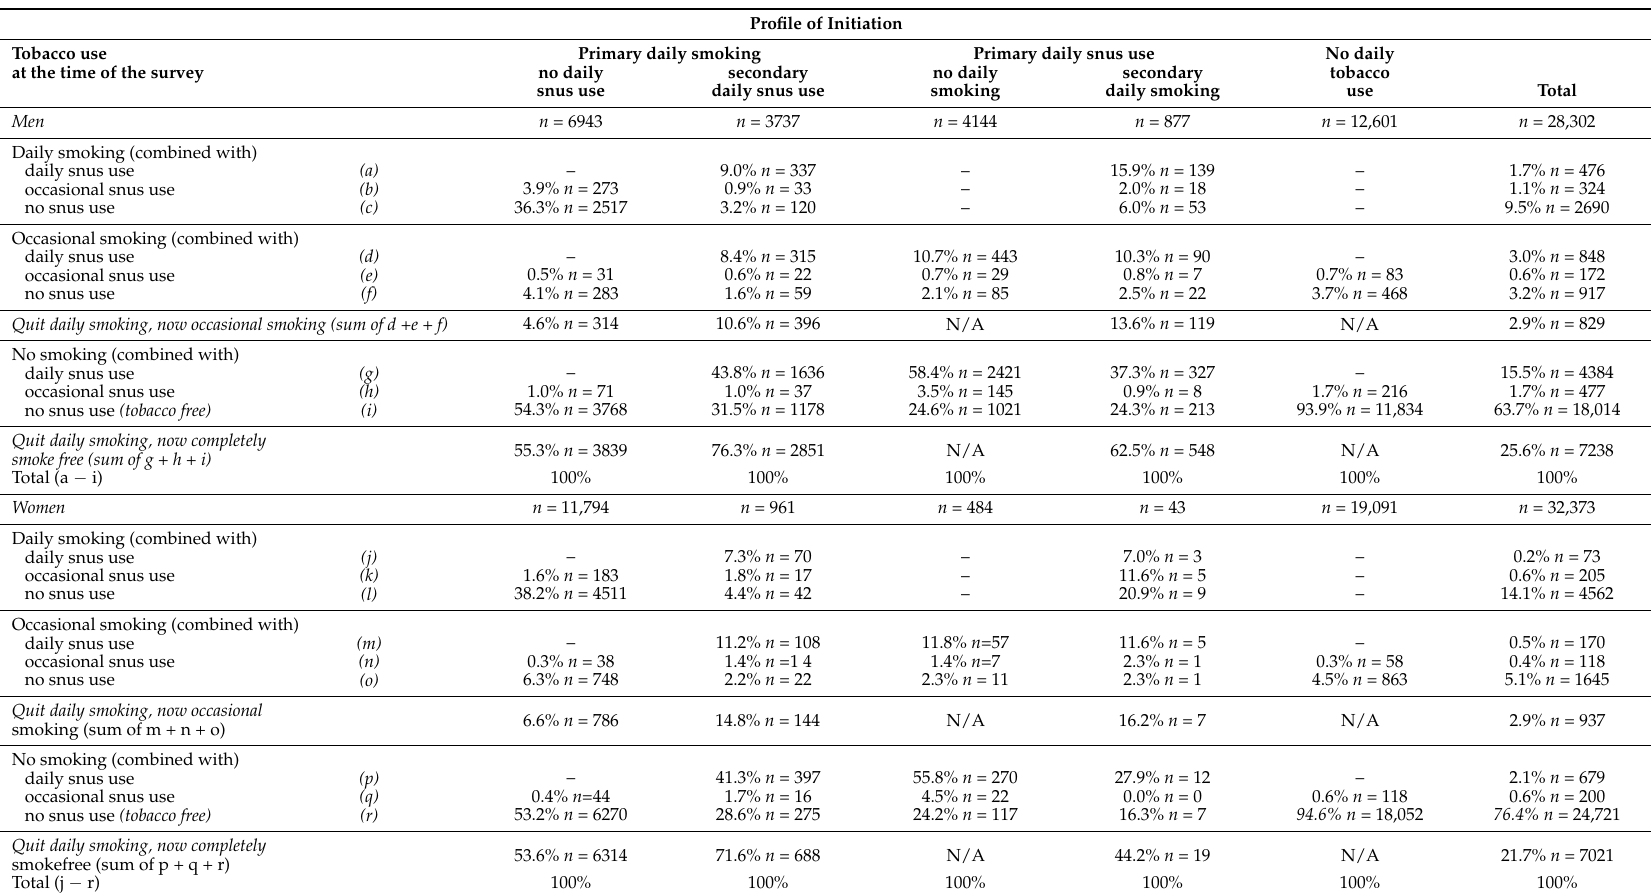
Table 1. Progression of tobacco use by profile of initiation of tobacco